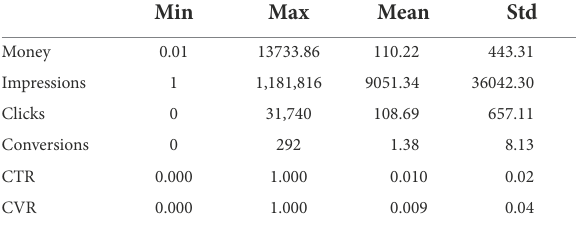
TABLE 2 Statistics of the